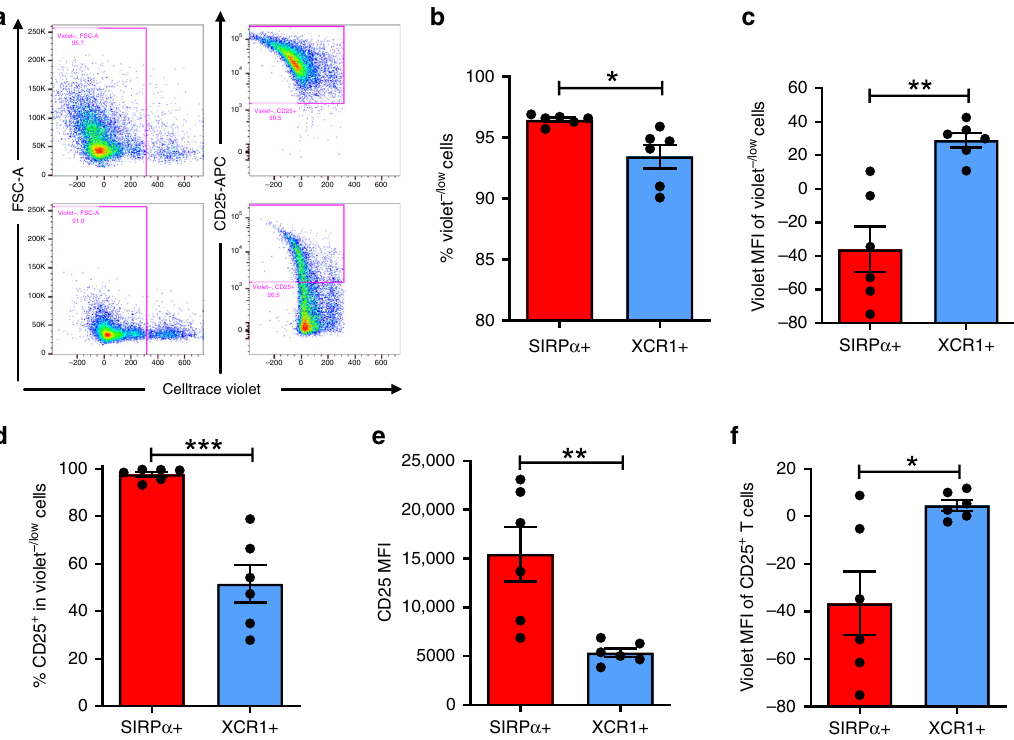
Fig. 6 SIRP α + DCs are superior to SIRP α − DCs in stimulating T cell responses. Flow cytometry-sorted splenic SIRP α + (XCR1 − CD11c + I-Ab + F4/80 − CD64 − ) or XCR1 + (SIRP α - CD11c + I-Ab + F4/80 − CD64 − ) DCs (Supplementary Fig. 5) were pulsed with 1nM OVA peptides (aa257-264), co-cultured with sorted OT-I mouse splenic CD3 + CD8 + T cells (pre-labeled with Celltrace Tm violet) for 3 days, then analyzed by fl ow cytometry for Violet fl uorescence dilution in T cells (i.e., proliferation) and CD25 expression on Violet − /low T cells. a Representative fl ow cytometry pro fi les showing Violet fl uorescence dilution in T cells (left) and CD25 expression on gated Violet − /low T cells (right) that were stimulated with SIRP α + (top) or XCR1 + (bottom) DCs. b Percentages of Violet − /low T cells. c Violet MFI (mean fl uorescence intensity) of Violet − /low T cells. d Percentages of CD25 + cells in Violet − /low T cells. e CD25 MFI of CD25 + Violet − /low T cells. f Violet MFI of gated CD25 + T cells. Results are combined from two independent experiments (total n = 6 per group) and presented as mean ± SEM. * p < 0.05; ** p < 0.01; *** p < 0.005 (unpaired t -test). Source data are provided as a Source Data fi